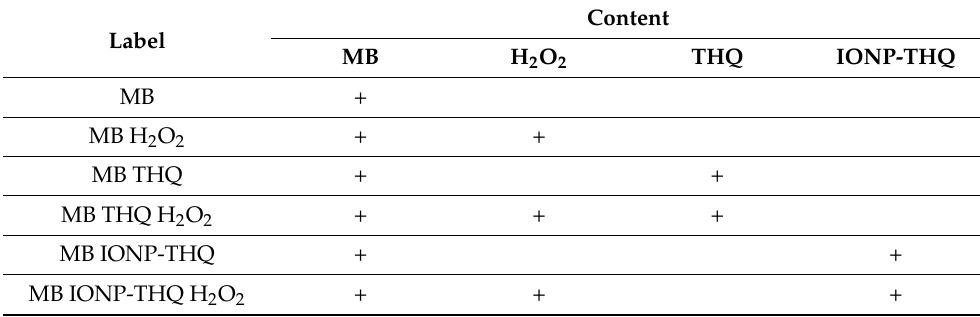
Table 1. Composition of the six labelled samples prepared to degrade methylene blue (MB).